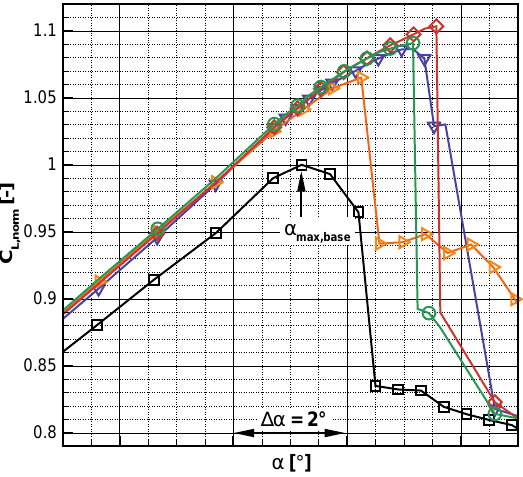
Figure 12. Lift coefficient for forcing with c µ ≈ 0.6%; see Figure 11 for the line legend.